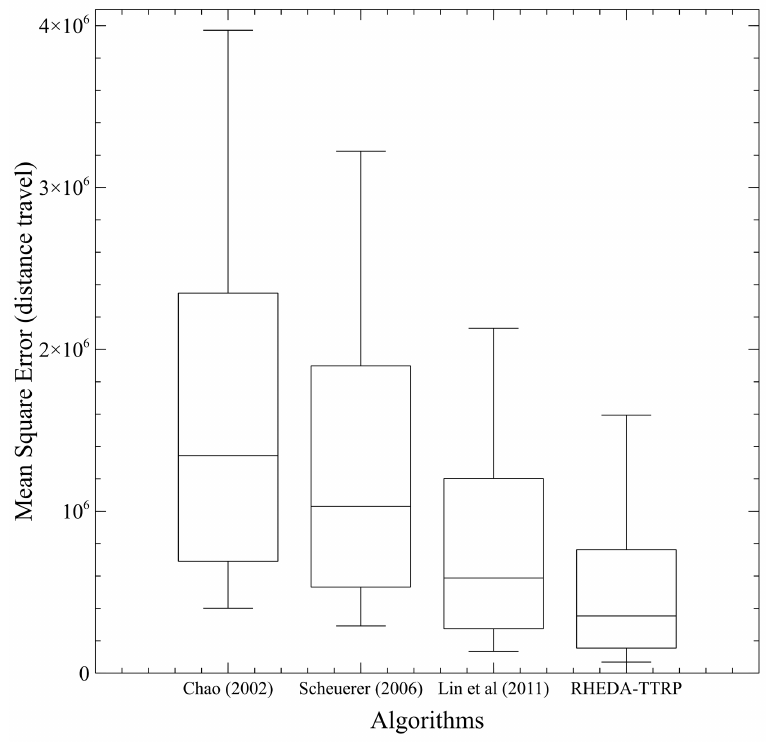
Figure 7. Algorithm Performance for the TTRP using the mean square error [30,31,34].